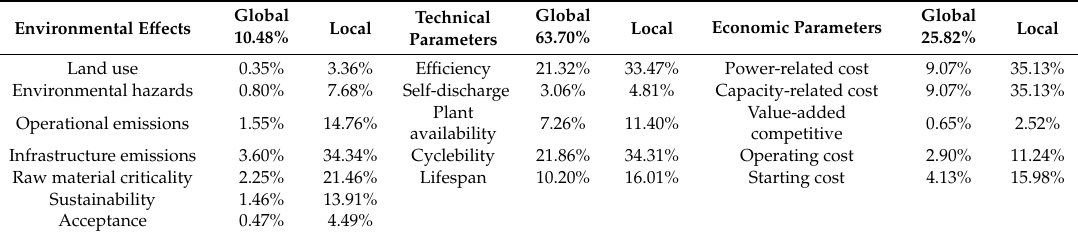
Table A9. Global and local weighing factors for medium-term electrical energy storage systems.